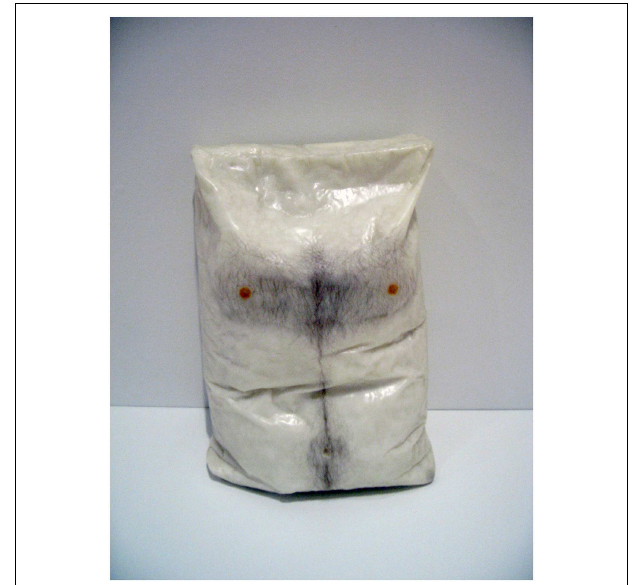
FIGURE 9 | Robert Gober, Untitled , 1990, Beeswax, pigment, and human hair, 60 × 44 × 29cm, San Francisco Museum of Modern Art. Photograph by the author. © Robert Gober, Courtesy Matthew Marks Gallery.